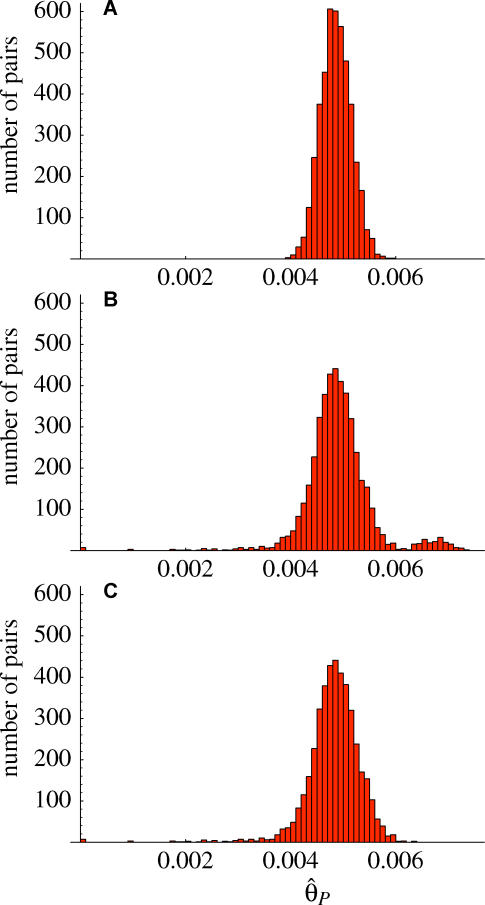
The Distribution of Pairwise Differences (SNPs Only) between All Pairs of Accessions(A) An example of the distribution we would expect to see in the absence of population structure, obtained by randomizing genotypes with respect to individuals for each sequenced fragment.(B) The observed distribution.(C) The observed distribution with accessions Cvi-0 and Mr-0 removed.